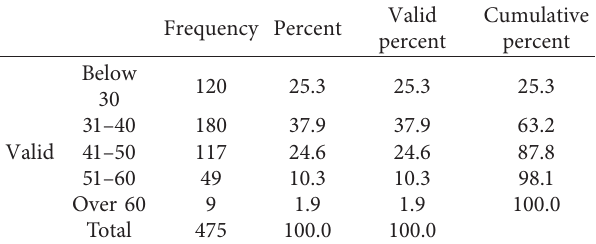
Table 2: Age of the respondents.